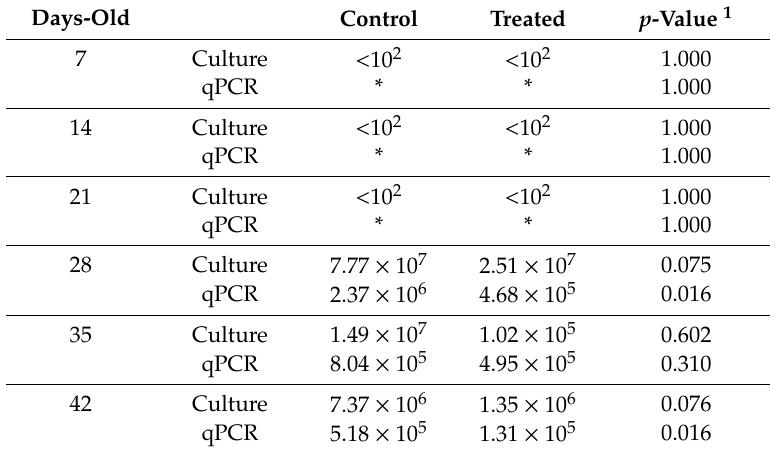
Table 3. Results of culture (CFU / g) and qPCR (genome equivalent / g) in 21-day-old challenged chickens.